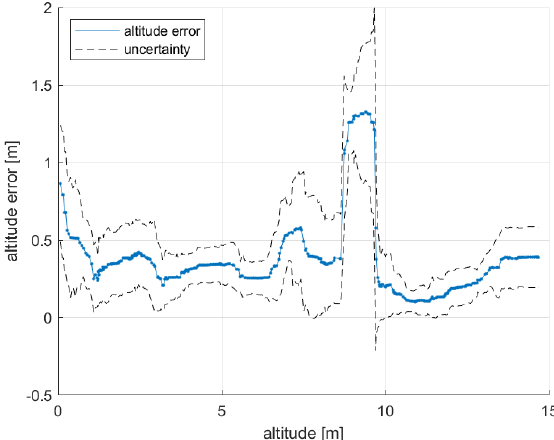
Figure 10. Height component of the positioning error varying the drone altitude (Gauss-Newton algorithm based